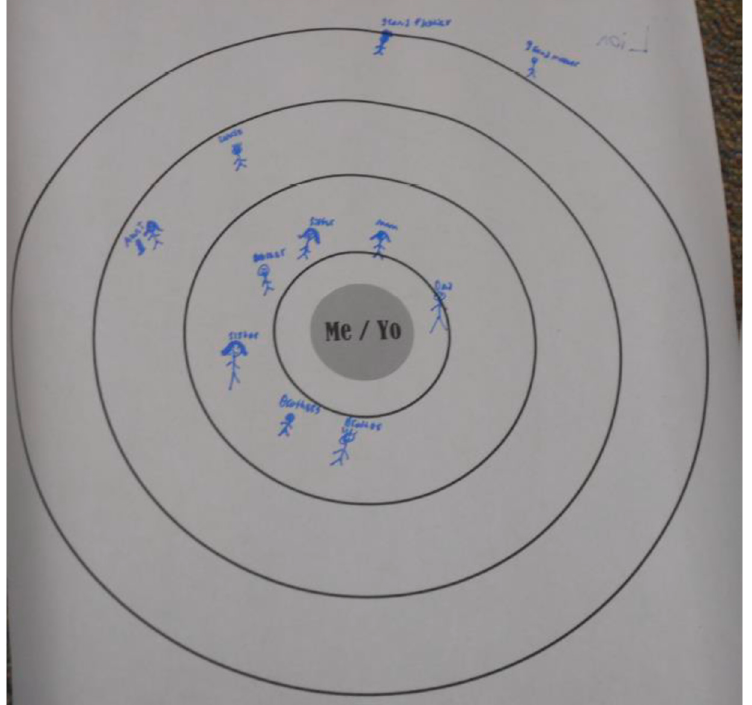
Figure 3. Example of Convoy Model filled out during a focus group discussion.